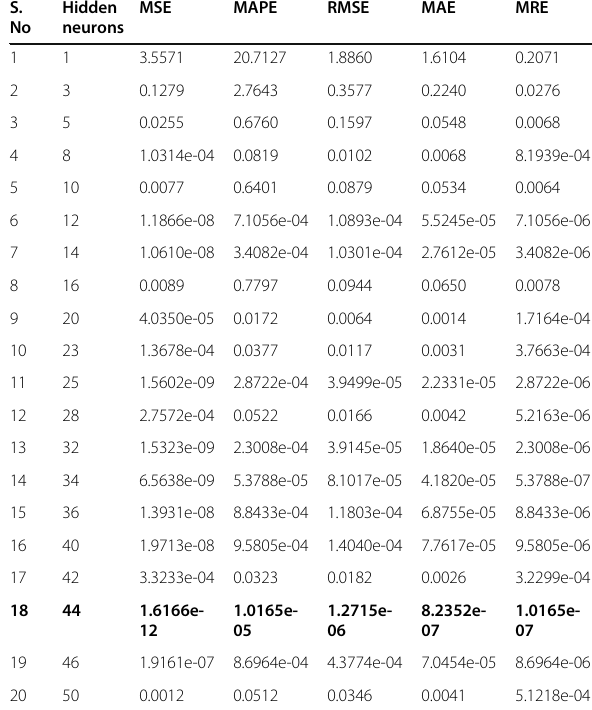
Table 5 Performance analysis of the proposed model with various hidden